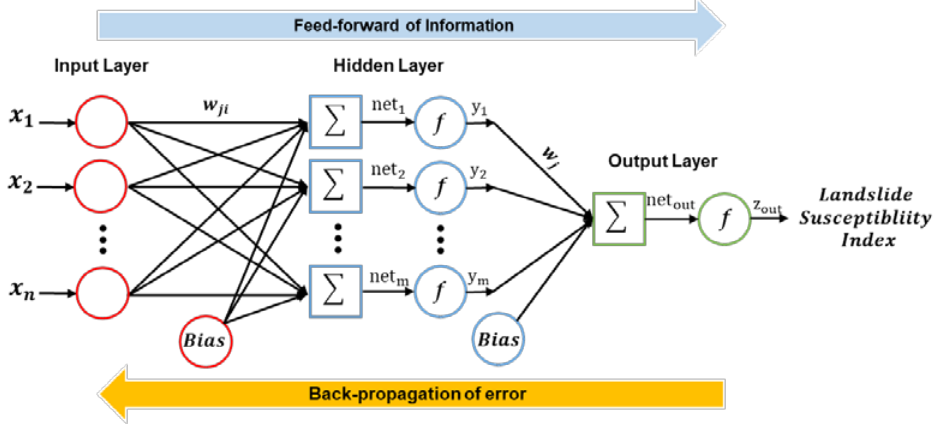
Figure 5. Architecture of the multi-layer perceptron (MLP) model.